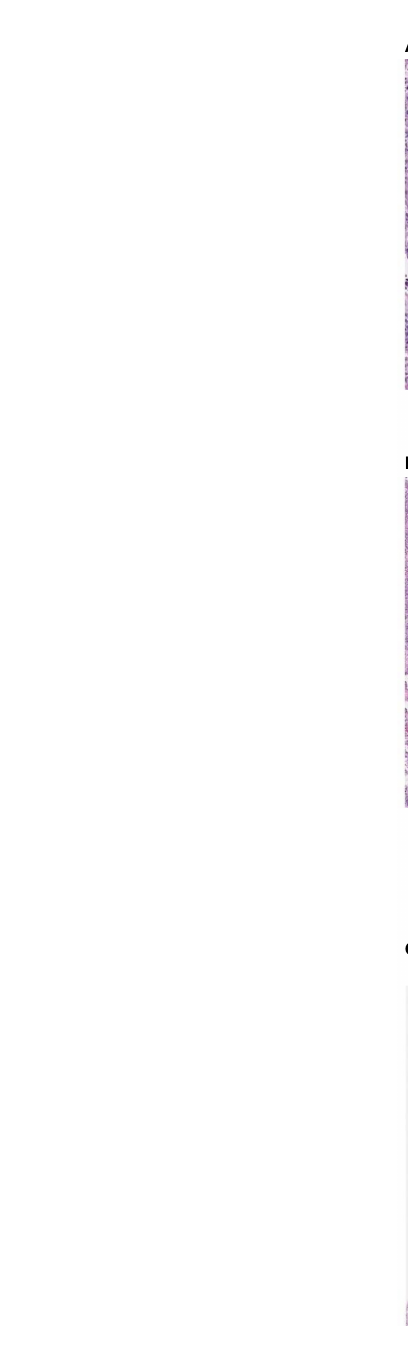
FIGURE 2 | Pulmonary wedge biopsy, Day +55. (A) Patchy consolidation, 2x. (B) Organizing pneumonia with fi broblastic proliferation in terminal airways and numerous macrophages occupying airspaces, 10x. (C) Pulmonary arterial thrombus with alternating bands of fi brin and platelets (lines of Zahn), 4x. (A – C) . Hematoxylin and eosin stain, magni fi cations using Leica Biosystems Aperio